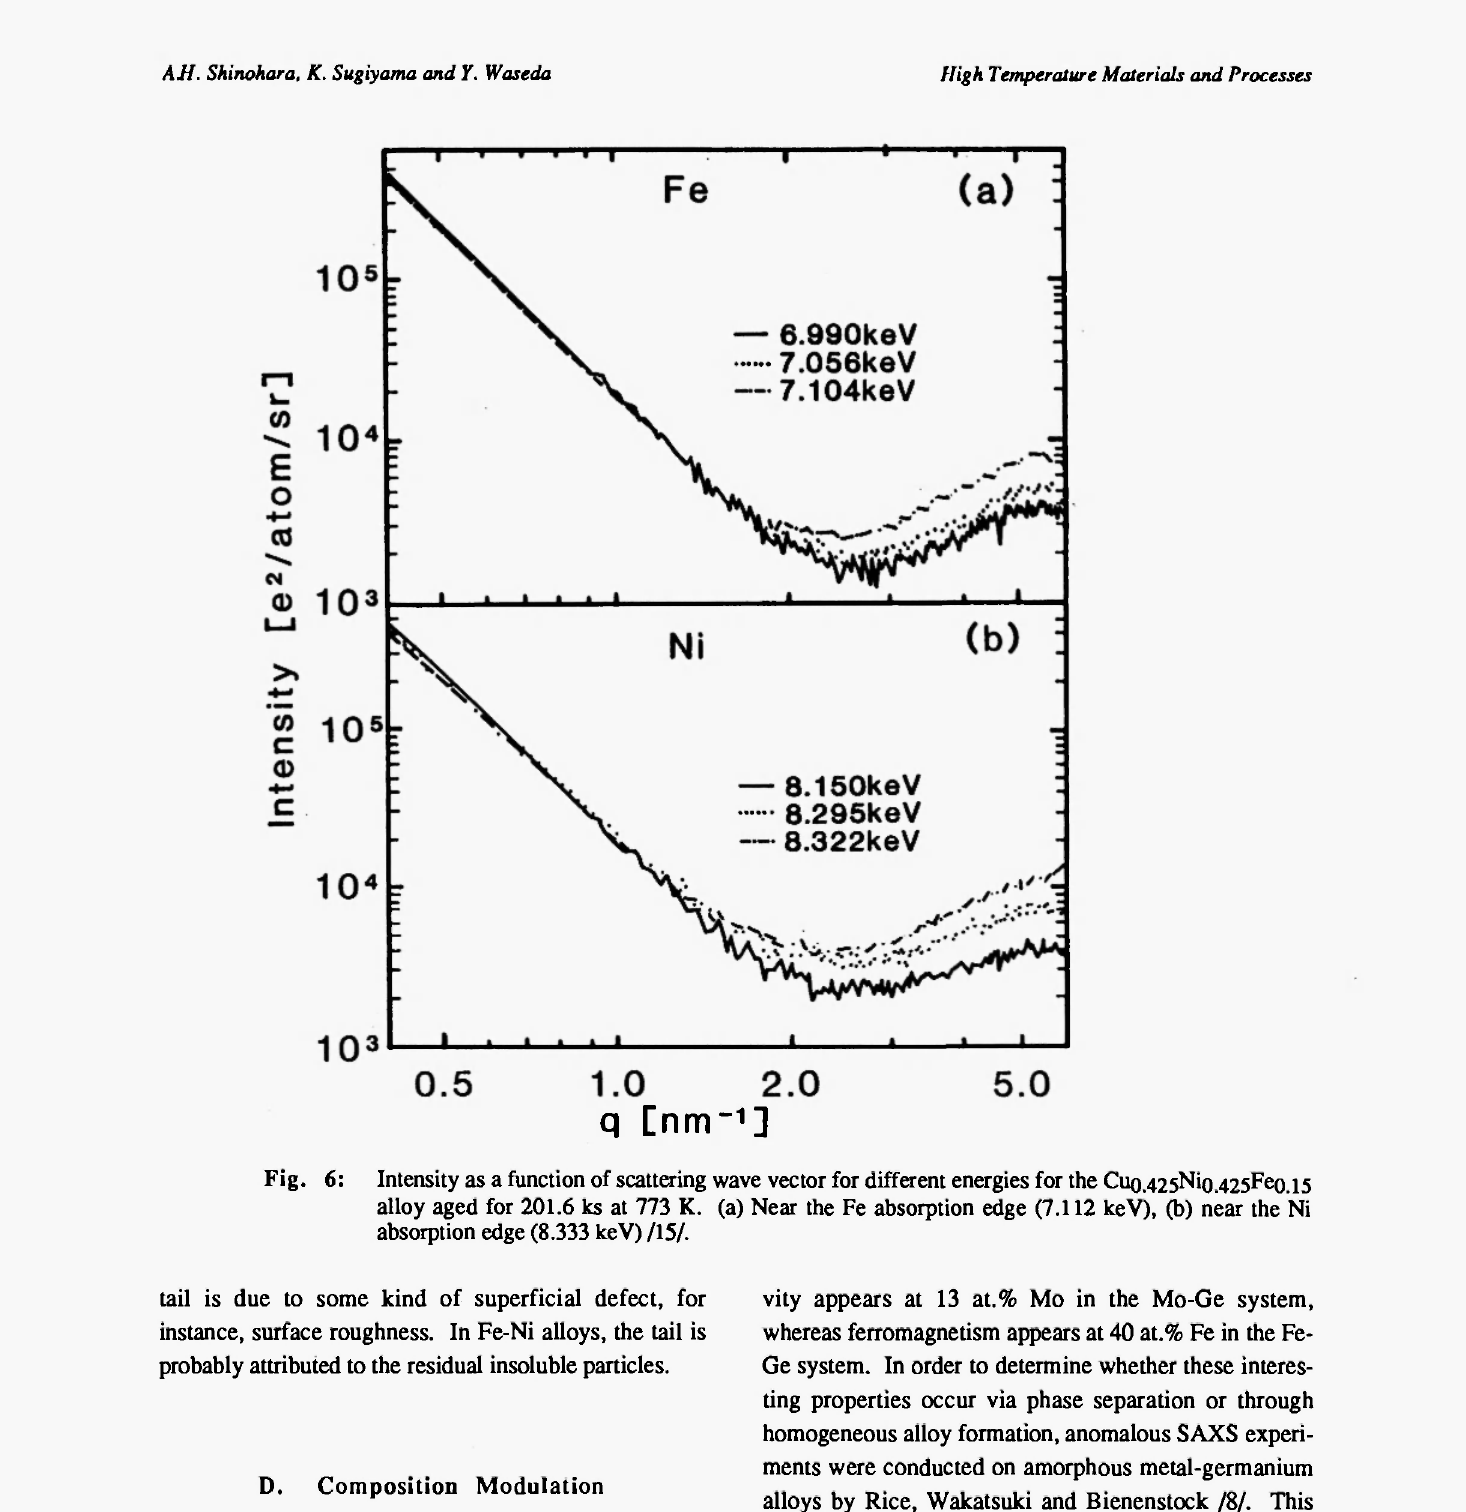
q [ n m _ 1 Fig. 6: Intensity as a function of scattering wave vector for different energies for the Cuo.425Nio.425 Fe 0.15 alloy aged for 201.6 ks at 773 K. (a) Near the Fe absorption edge (7.112 keV), (b) near the Ni absorption edge (8.333 keV) /15/.